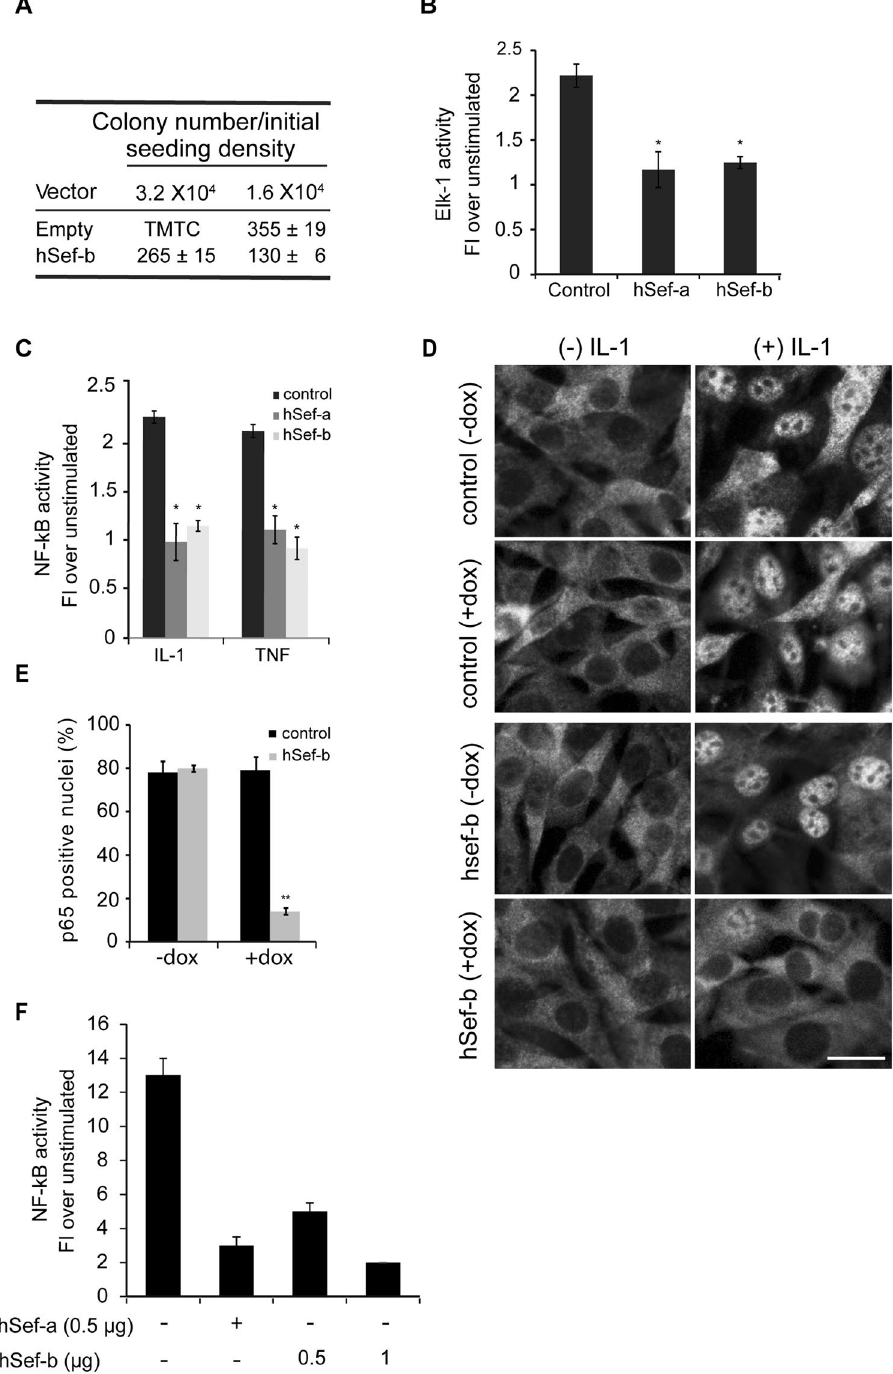
Figure 1. ( A ) hSef-b suppresses colony formation in TRAMP C2 cells. Cells were stably transfected with 5 µ g hSef-b (pCDNA/hSef-b) or an empty vector (pCDNA) along with eGFP construct (0.1 µ g) for monitoring transfection efficiency. After one day, transfection efficiencies were microscopically monitored, cells were seeded at different densities and selected with G418 for ~2 weeks. Clones were counted at the end of the selection process. The results are normalized to transfection efficiencies, and are representative of 2 independent experiments. TMTC denotes: too many to count. ( B , C ) hSef isoforms suppress ERK/MAPK and NF- κ B in TRAMP C2 cells. Cells were transfected with Elk-1 or NF- κ B- luciferase reporter plasmid along with a control empty vector or with hSef-a or hSef-b expression vector. Cells were treated with FGF2 (2.5 ng/ml) for inducing Elk-1 activation, and with IL-1 or TNF (5 ng/ml) for inducing NF-kB activation. Error bars indicate SEM (N = 2, * p < 0.05). ( D , E ) hSef-b attenuates IL-1 induced NF- κ B (p65) nuclear translocation in TRAMP C2 cells. Control or hSef-b Tet on/TRAMP C2 cells were grown in the absence or presence of dox for 24 hr, then stimulated for 15 minutes with 5 ng/ml IL-1 and immunostained with α -p65 antibody. Representative